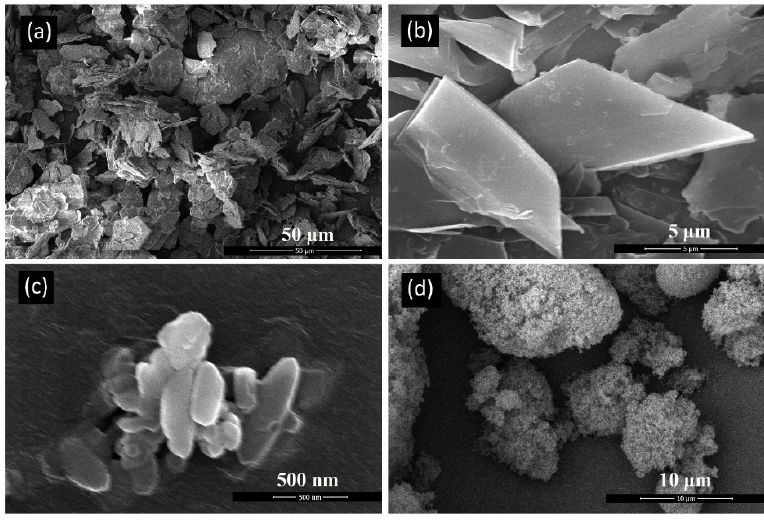
Figure 4. SEM micrographs of the initial powders ( a , b ) talc, ( c ) calcium carbonate, and ( d ) silica.